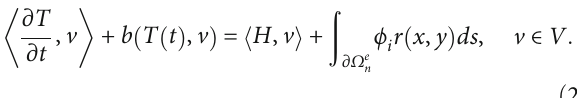
Figure 2: The numerical solution, exact solution, and absolute error between them, respectively, when the exact solution is linear. Table 2: Comparison of the exact and the numerical solutions using the fi nite element method for Δ t = 0 : 1 , α = 1 , and N = 10